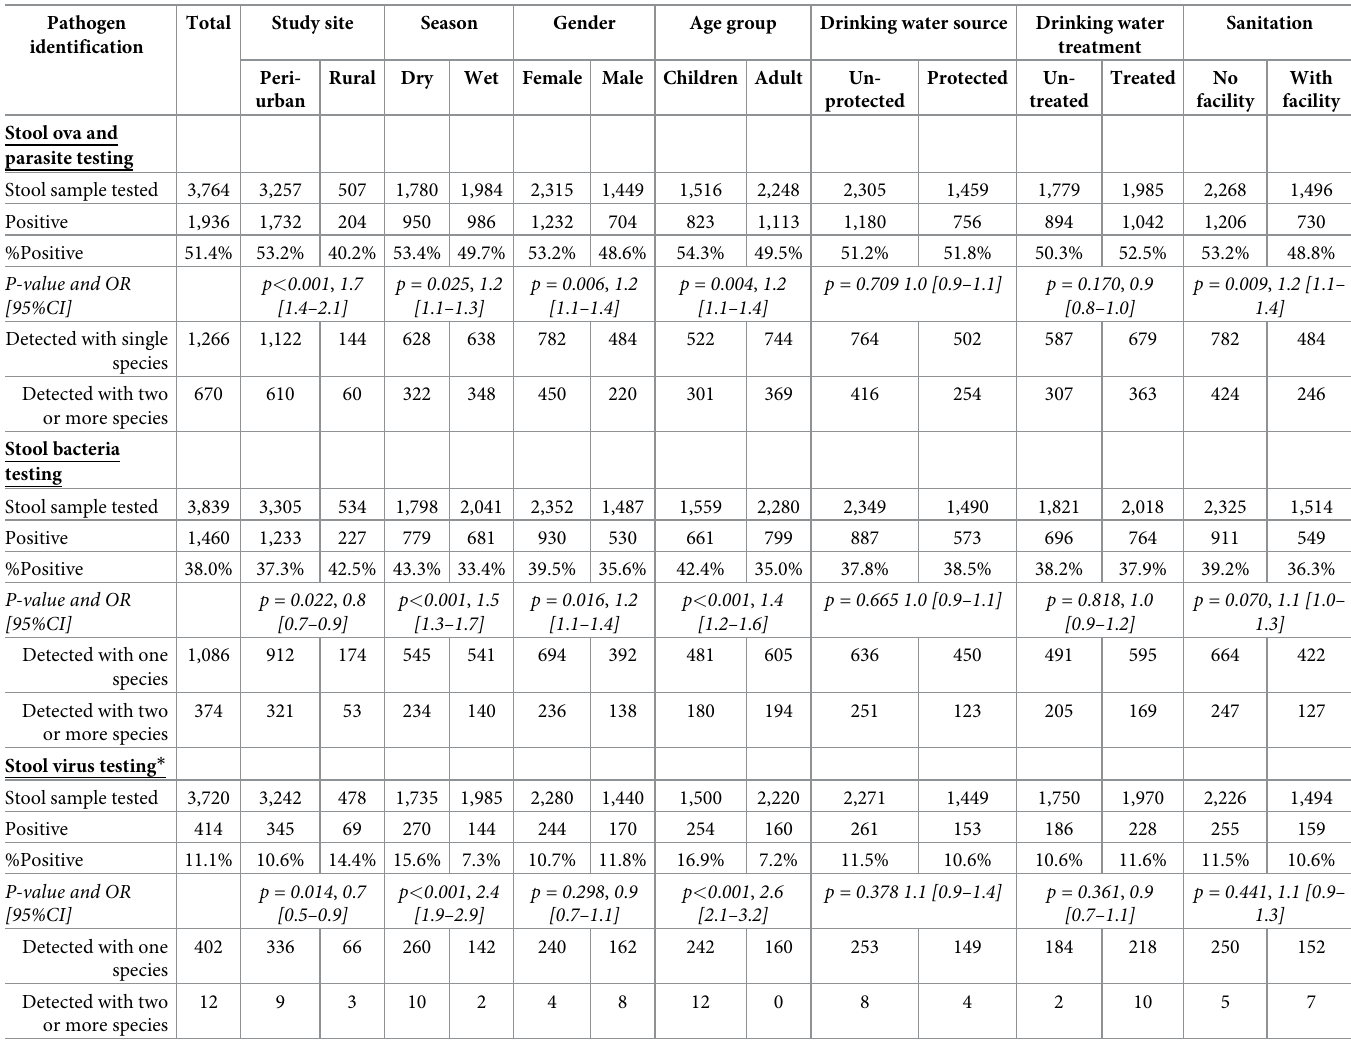
Table 5. Pathogens identified by laboratory testing type and stool specimen sample